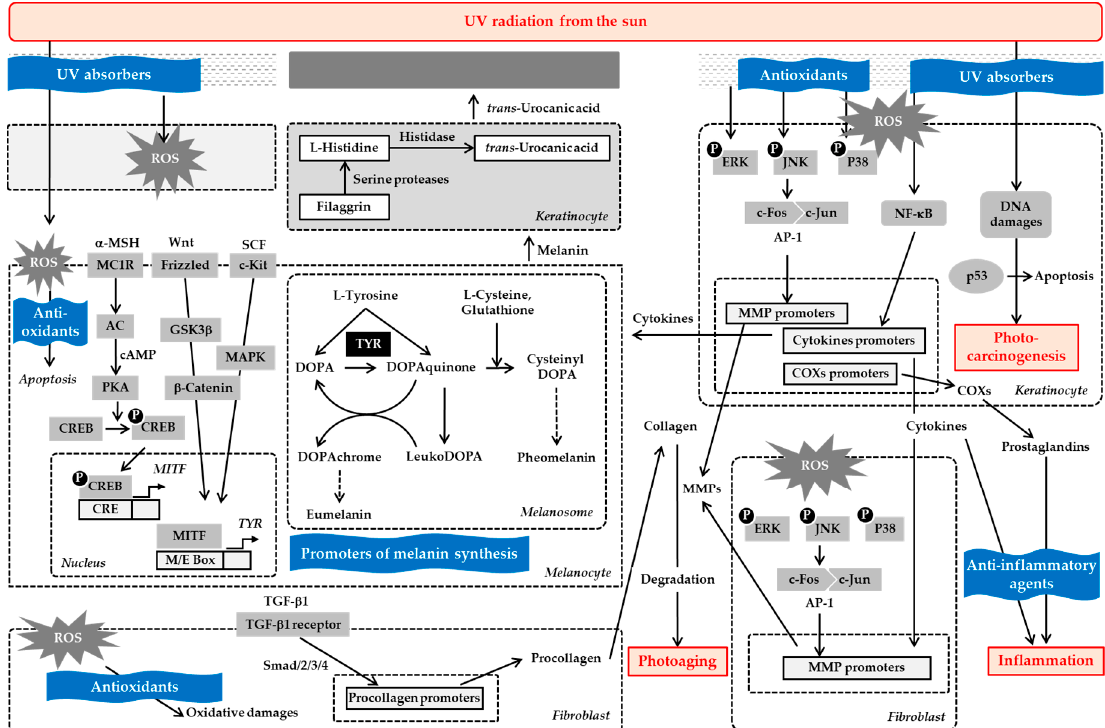
Figure 3. Emerging strategies using plant-derived materials to protect the skin from ultraviolet (UV)-induced damage. Overexposure of the skin to UV radiation induces production of reactive oxygen species (ROS), gene expression of matrx metalloproteinases (MMPs), cytokines, and cyclooxygenases (COXs), p53 activation, and oxidative damages in DNA and other biomolecules. These can lead to photoaging, inflammation, apoptosis, and/or photocarcinogenesis. Melanin and trans-urocanic acid provide UV-defensive measures. Research has shown that various plant-derived materials, such as botanical extracts, flavonoids, phenylpropanoids, carotenoids, coumarins, iridoids, terpenoids, polysaccharides, and saponins, can help mitigate UV-induced toxicity. Plant-derived materials can act as UV absorbers, antioxidants, anti-inflammatory agents, and/or promoters of melanin synthesis. Future clinical studies are needed to determine whether these UV defense strategies using plant-derived materials can reduce the incidence or progression of photoaging, inflammation, and photocarcinogenesis in humans.